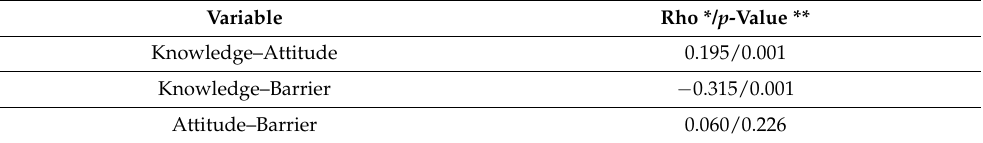
Table 8. Correlation between knowledge, attitude, and barriers scores (Spearman’s rank